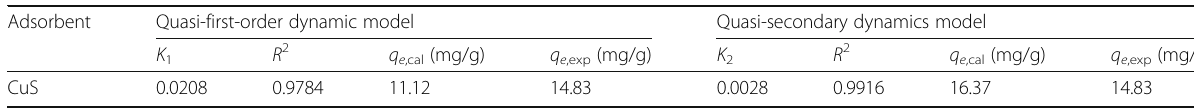
Table 1 Related parameters of the kinetic model of copper sulfide on EE2